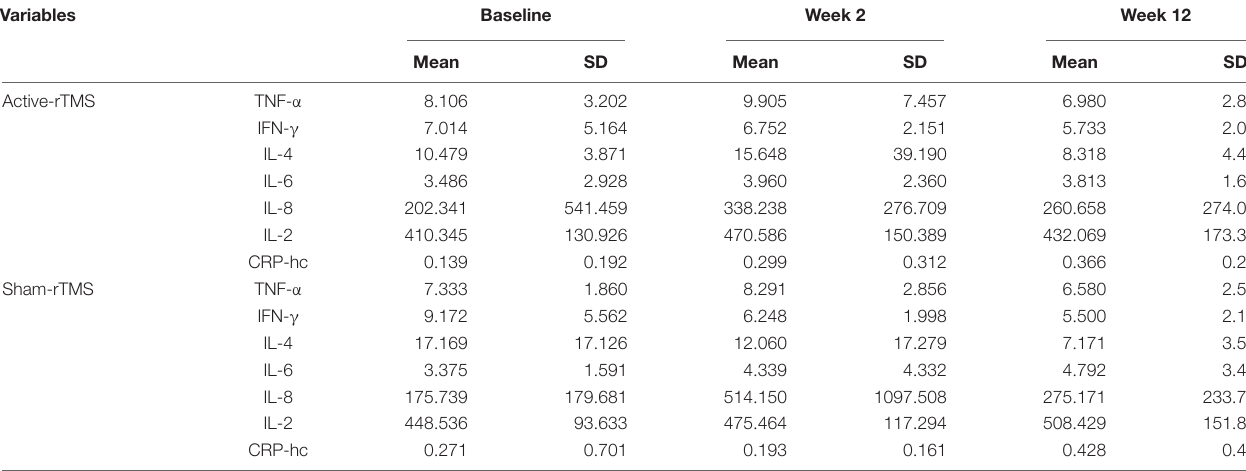
TABLE 3 | The levels of inflammatory cytokines at baseline, 2 and 12 weeks in the active-rTMS and sham-rTMS groups in patients with depression. Variables